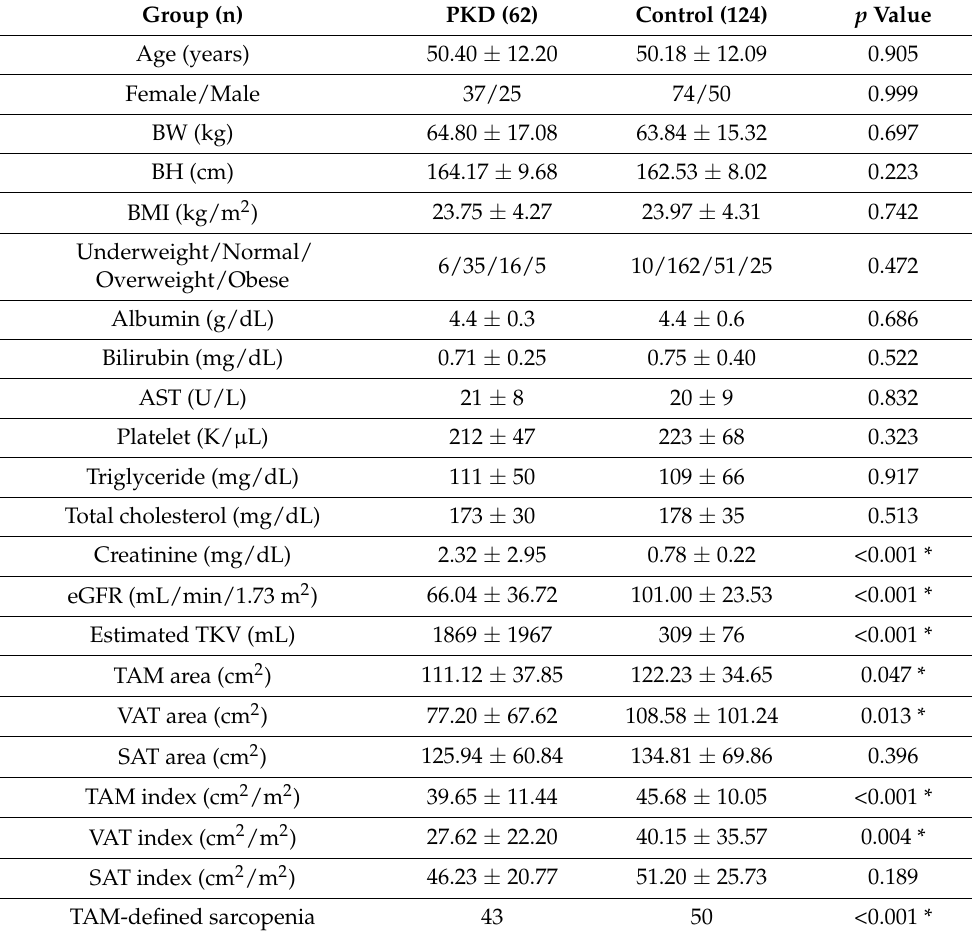
Table 1. Demographic data of patients with polycystic kidney disease and controls (52 potential liver donors and 72 patients with appendicitis).